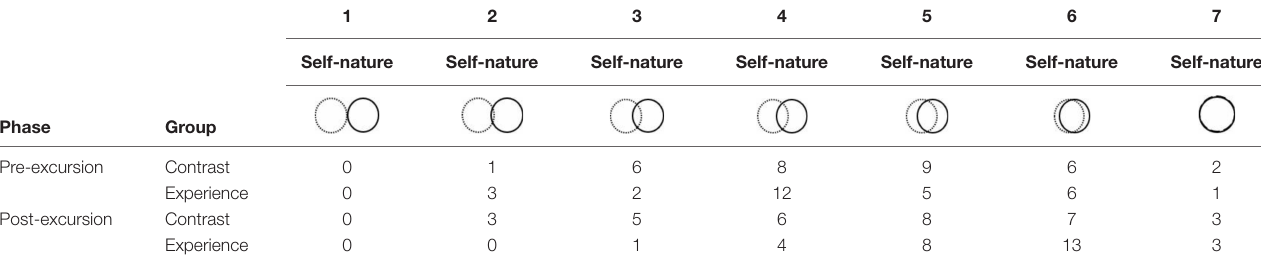
TABLE 2 | Inclusion of nature in self item frequencies.